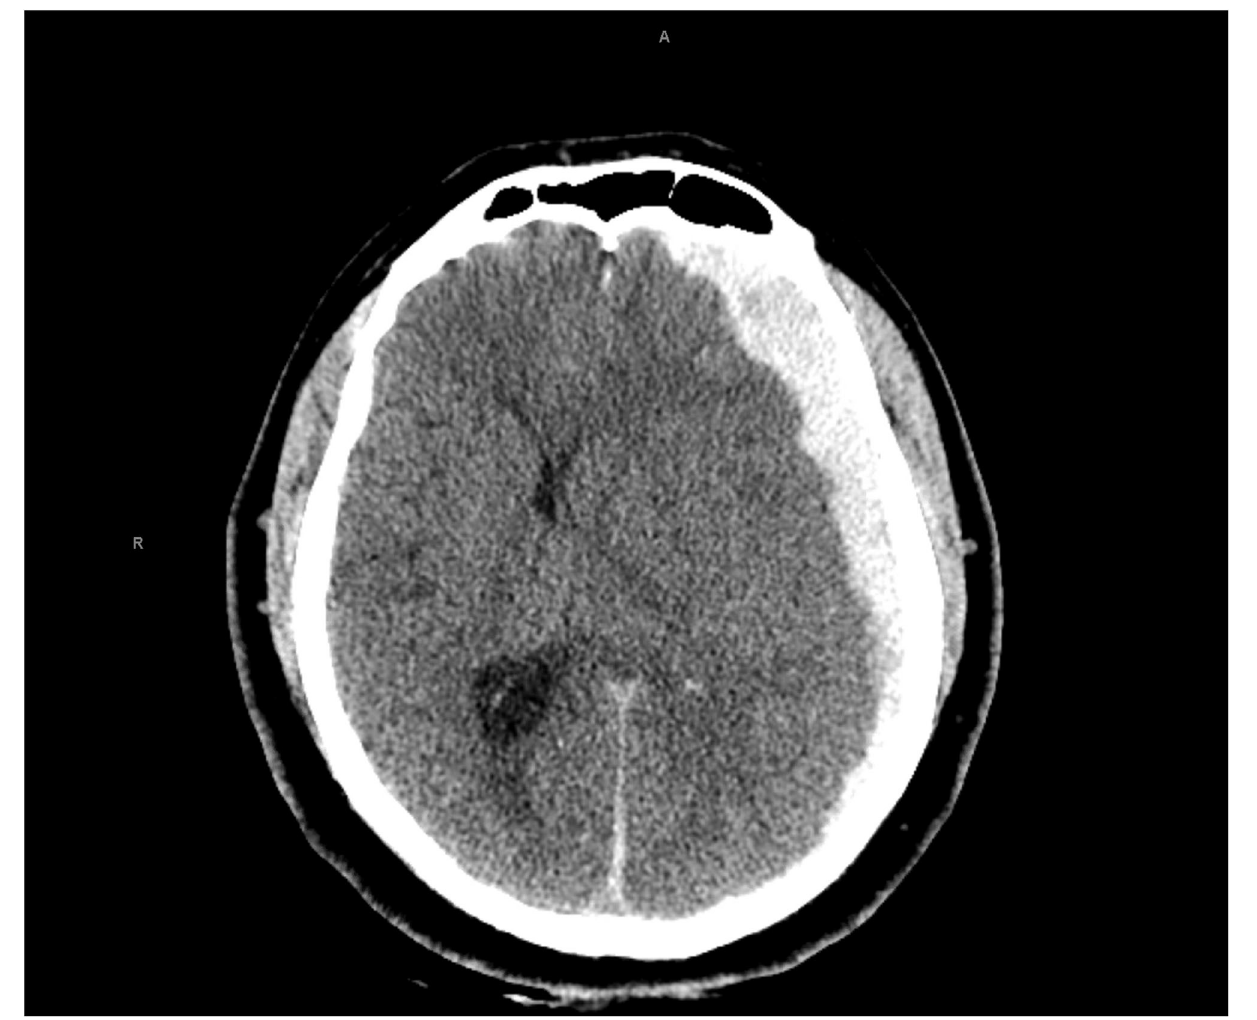
FIGURE 2 | Computed tomography head showed an acute left subdural hemorrhage with significant left-to-right midline